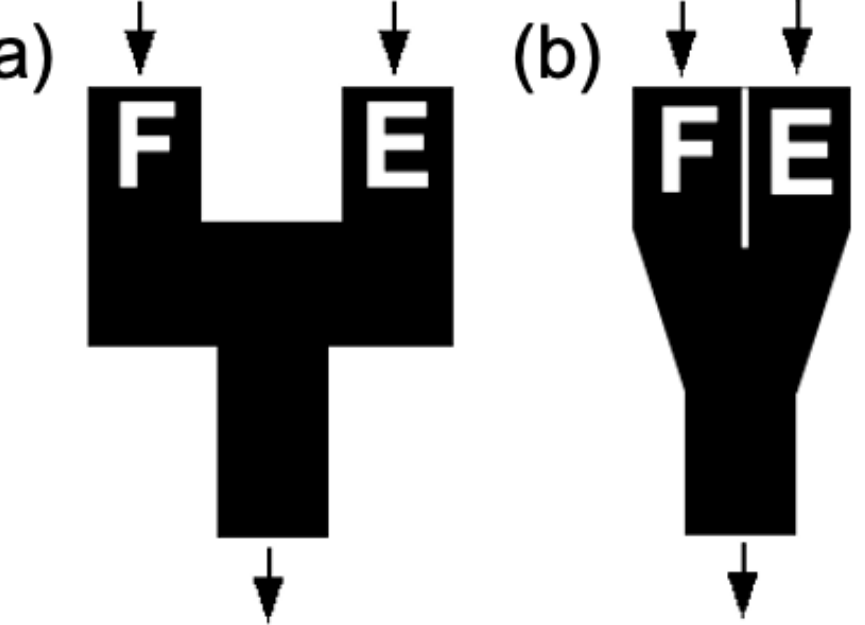
Figure 1. Diagrams of the Y-mazes used in these experiments. The first set of experiments used the block-shaped Y ( a ), while the second and third sets of experiments used the angled Y-maze ( b ). Seawater flowed through the mazes from top to bottom in the diagram, with food-cue water (F) coming from one side and the control water with no cues from the empty (E) side of the fork. Arrows show the direction of water movement in the Y-maze.